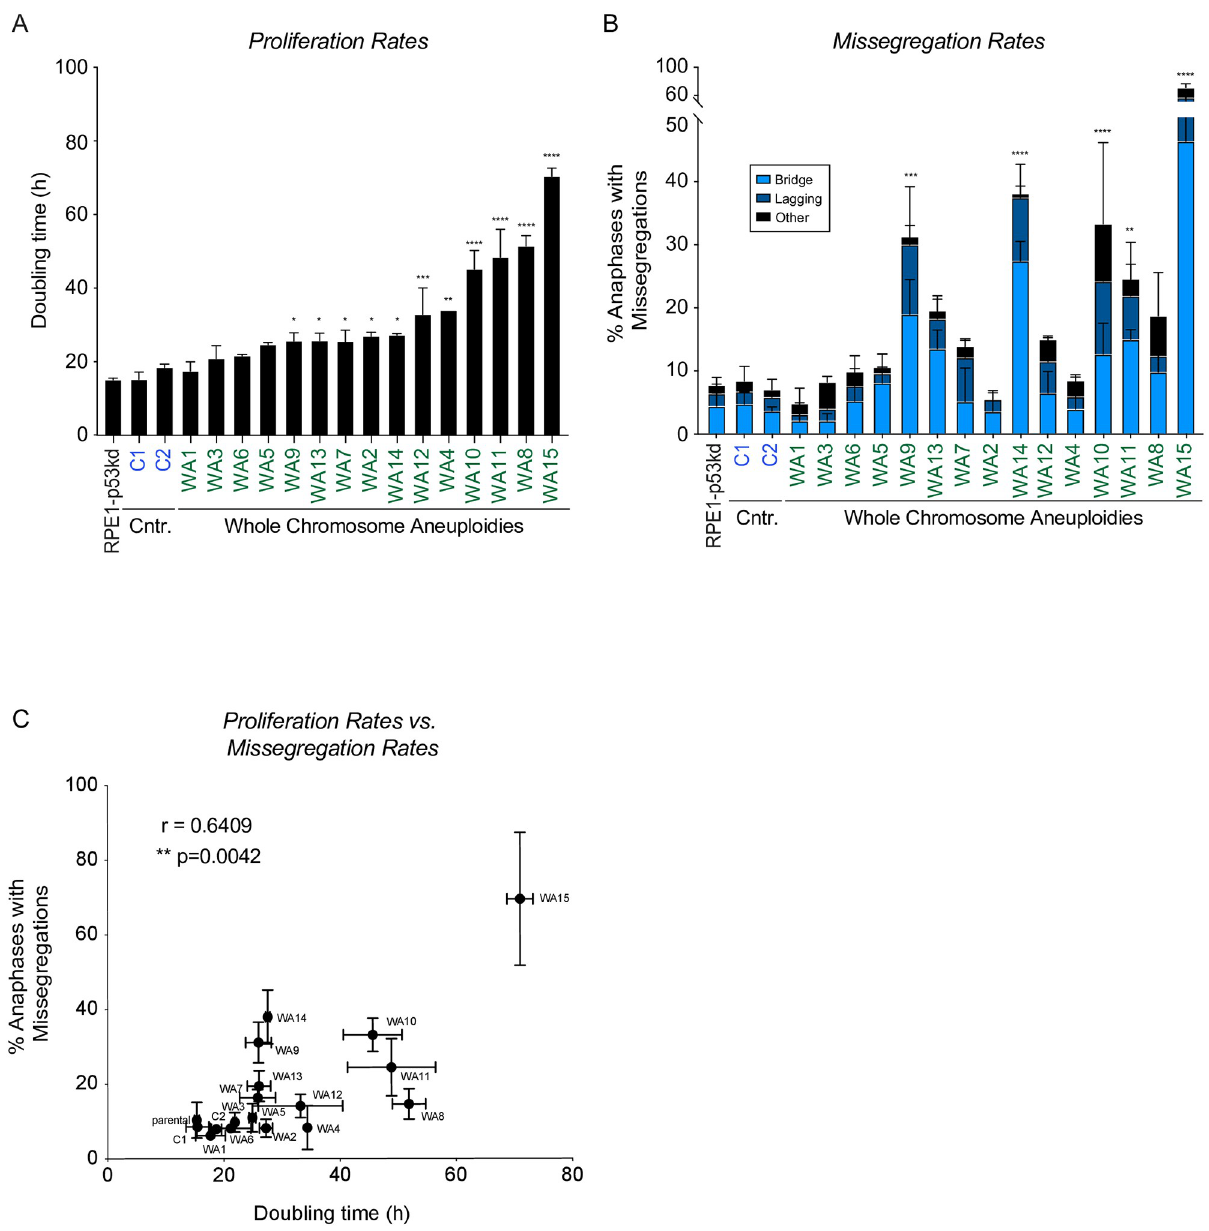
Fig 1. Aneuploid clones show a spectrum of different doubling times and mis-segregation rates. A. Doubling time of the parental cell line (labeled in black), two euploid clones (blue) and aneuploid clones (green) determined via live cell imaging. Error bars indicate standard deviation. An ordinary one-way ANOVA was performed between clones and parental cells. P-values are assigned according to GraphPad standard. B. Chromosome missegregation rates determined by live cell imaging of parental RPE-1 p53KD cells (labeled in black), euploid (blue) and aneuploid (green) clones from S1 Fig, divided into three subcategories: lagging DNA, anaphase bridges and others (multipolar spindle, polar chromosome, cytokinesis failure, binucleated cell). All conditions were analyzed blinded. Bars are averages of at least 2 experiments and a minimum of 50 cells were filmed per clone. Error bars indicate standard deviation. An ordinary one-way ANOVA was performed between parental and clones. P-values are assigned according to GraphPad standard. C. Spearman correlation between the proliferation rate as measured in A and the missegregation rates as a percentage of anaphases as measured in